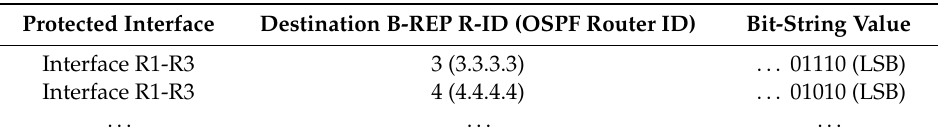
Table 2. B-REP BP